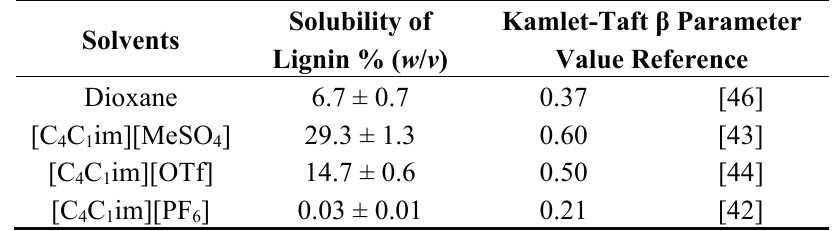
Table 1. Solubility of original Kraft lignin at 55 °C in the reaction media used for its enzymatic transesterification and their respective Kamlet-Taft β